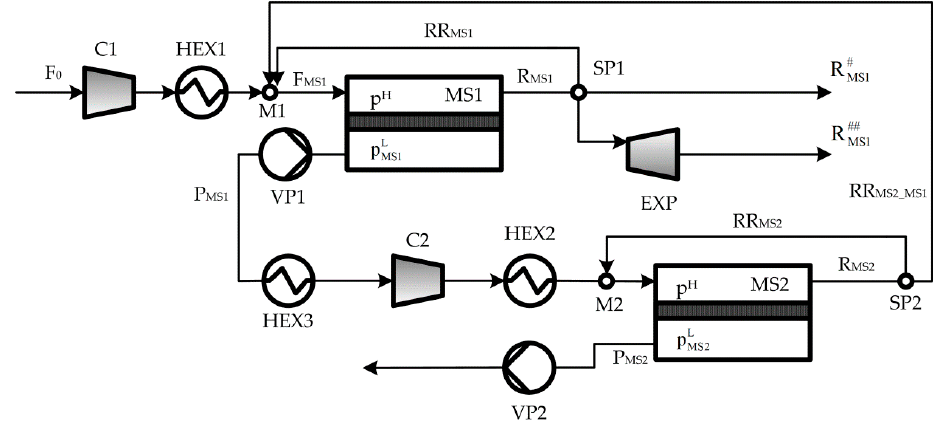
Figure 1. Schematic of the studied two-stage membrane process for H 2 separation. (MS represents membrane units, C compressors, HEX heat exchangers, VP vacuum pumps, EXP expansion turbine (expander), SP splitters, M mixers. P MS represents the permeate stream in MS, R MS retentate stream in MS, RR MS (internal) retentante recycle in MS, RR MS2_MS1 (external) retentate recycle from MS2 to MS1, R ## represents the fraction of R that is expanded in EXP and R # the fraction of R that is not expanded in EXP, and p H and p L indicate high and low pressure, respectively).